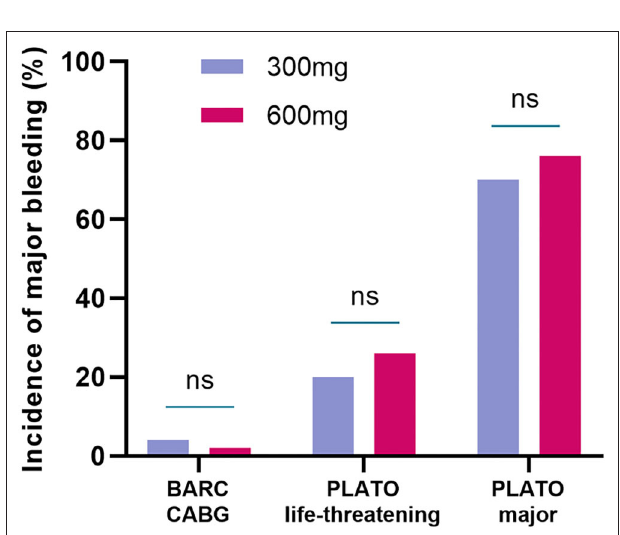
FIGURE 3 | The incidence of major bleeding events in randomized groups. The incidence of BARC CABG, PLATO life-threatening bleeding, and PLATO major bleeding were not statistically significant between the 300-mg group and 600-mg group. BARC, bleeding academic research consortium; CABG, coronary artery bypass grafting; PLATO, platelet inhibition and patient